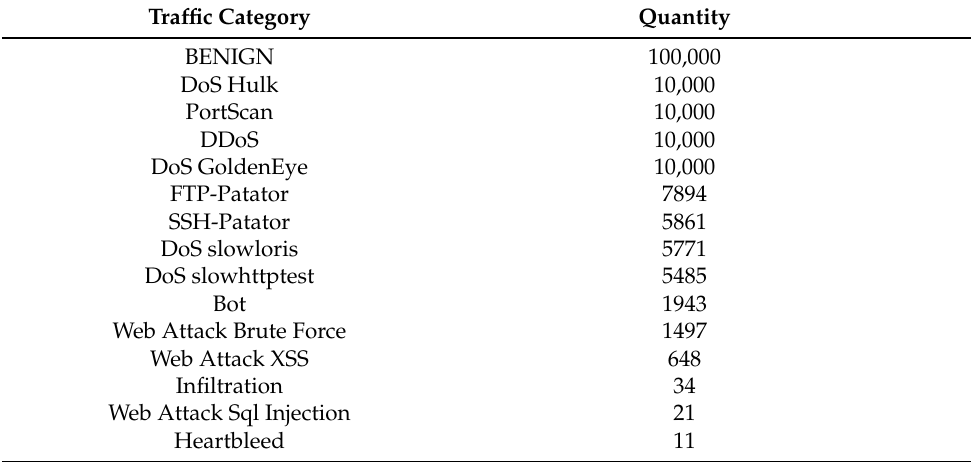
Table 4. Data quantity in experiment